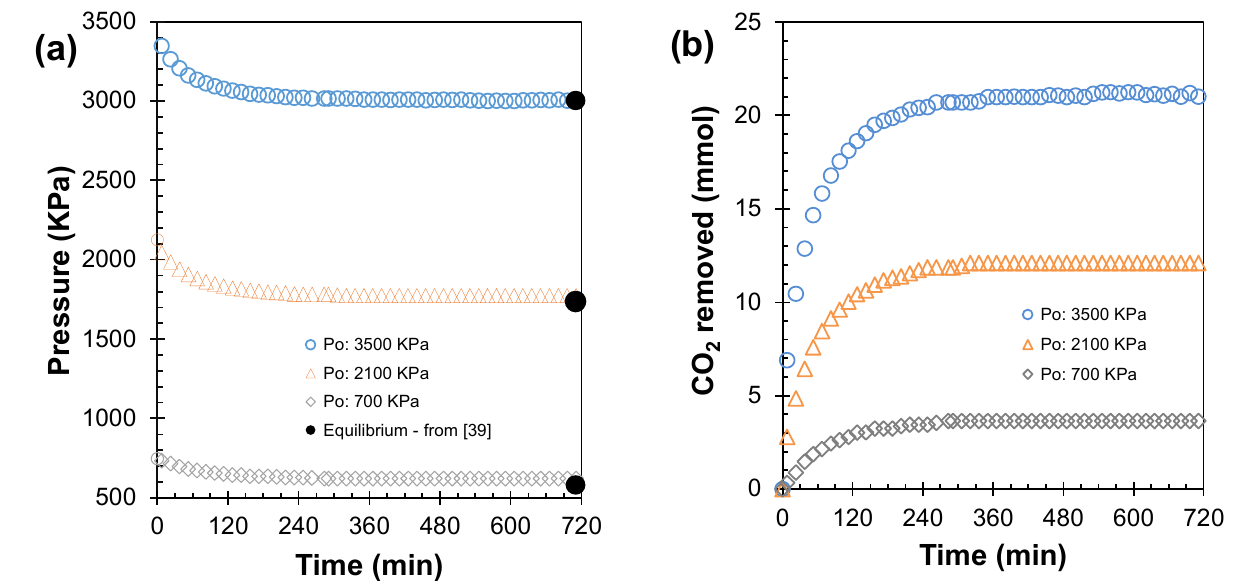
Figure 2. CO 2 solubility testing: ( a ) pressure vs. time; ( b ) CO 2 removed vs. time. Table 1. CO 2 solubility testing: Kinetic and thermodynamic data.